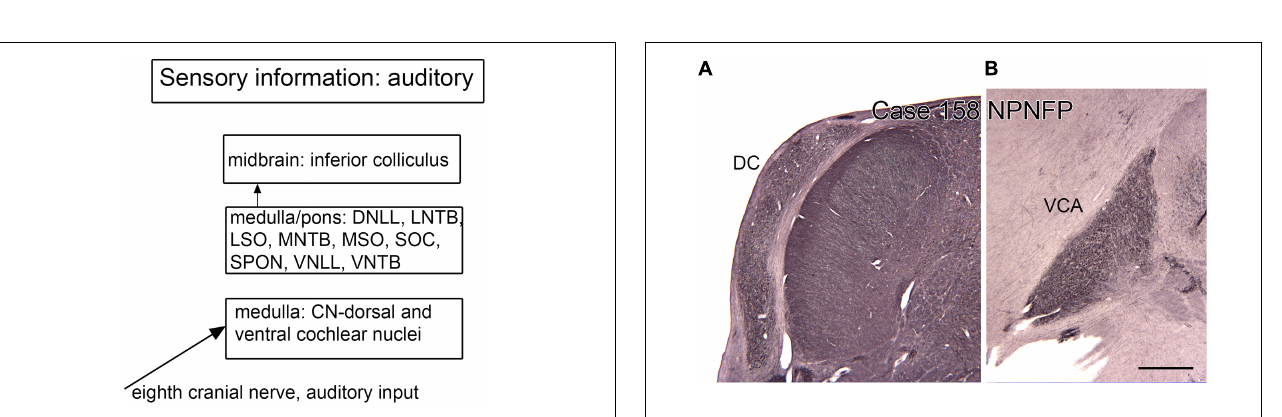
FIGURE 8 | The dorsal (DC, A ) and ventral (VCA, B ) cochlear nuclei in the human brain shown on transverse sections immunostained for non-phosphorylated neurofilament protein (NPNFP). Scale bar = 1 mm. forebrain bundle, innervating the amygdala, as well as dystrophic (abnormally large diameter) serotonergic fibers in ASD